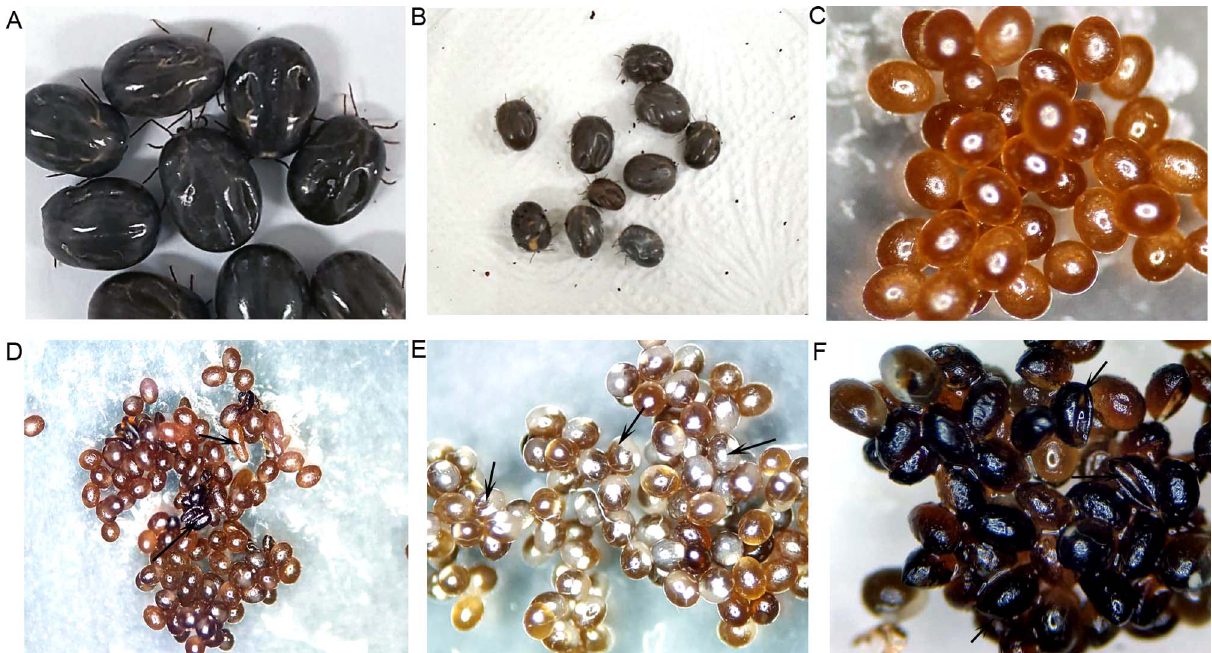
Figure 6. Phenotypic changes in tick ( Haemaphysalis longicornis) engorgement and egg morphology after GSK-3 b dsRNA treatment. (A) Control ticks; (B) GSK-3 b dsRNA-treated ticks after spontaneous drop-down; (C) Control tick eggs; (D) Abnormal eggs of GSK-3 b dsRNA-treated ticks; (E) Control tick eggs containing embryos; (F) Abnormal eggs (some have no